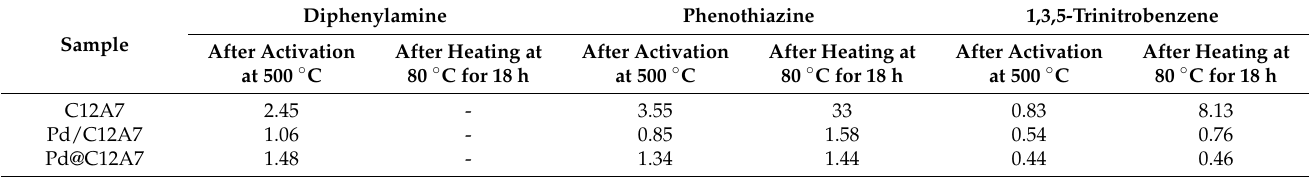
Figure 3. EPR spectra of Pd/C12A7 and Pd@C12A7 samples after adsorption of different spin probes: ( a ) TNB; ( b ) PTZ; ( c ) DPA. Table 2. Concentrations of radical species (10 18 g − 1 ) observed after the interaction of spin probe molecules to the active sites on the surfaces of C12A7, Pd/C12A7, and Pd@C12A7